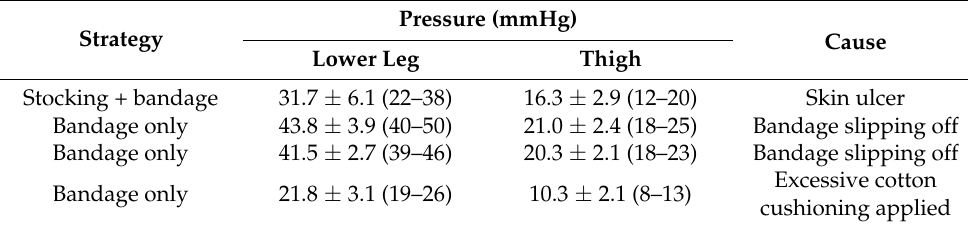
Table 2. Type of compression strategy used in patients in whom liposuction was unsuccessful.